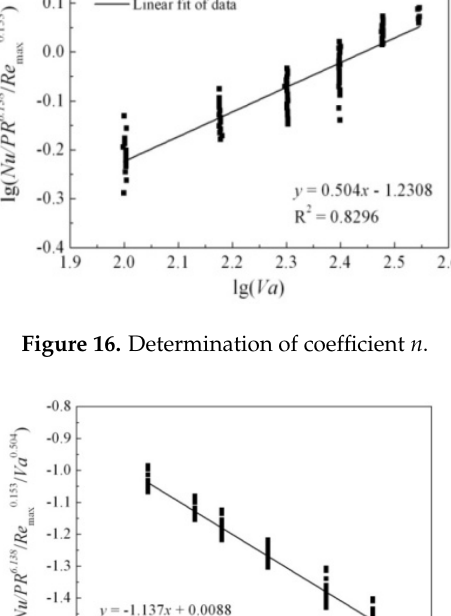
Figure 15. Determination of coefficient m .